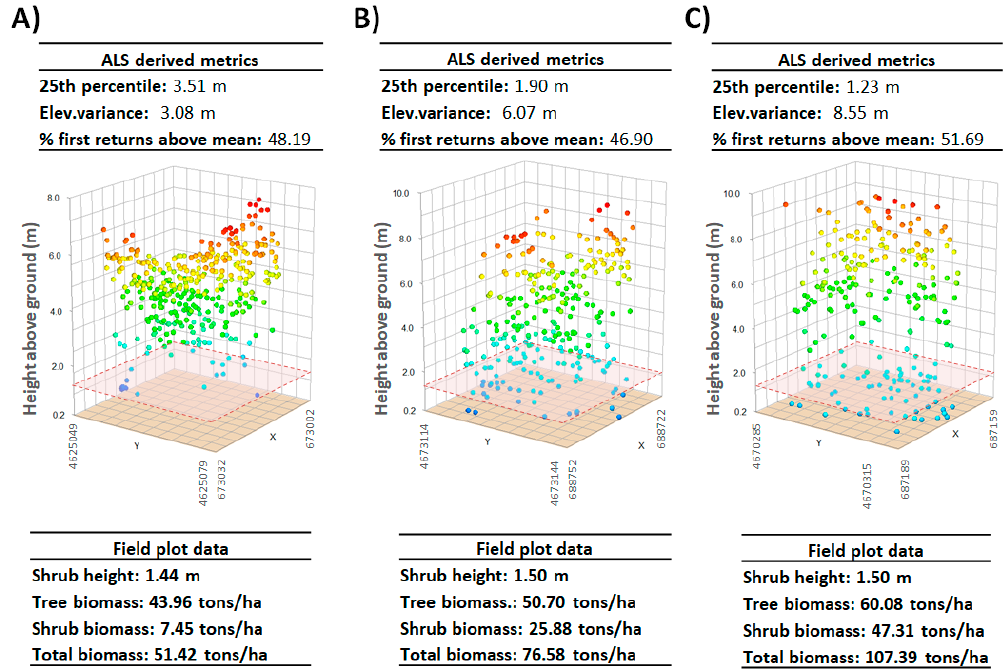
Figure 2. Airborne Laser Scanning (ALS) metrics associated with the vertical distribution of point cloud returns in three selected field plots representative of the study area: ( A ) smaller pines with low presence of shrubs (area B); ( B ) average height pines with an intermediate presence of understory (area A); ( C ) taller pines with high presence of shrubs (area A). The red square represents the average of the shrub height in each plot.